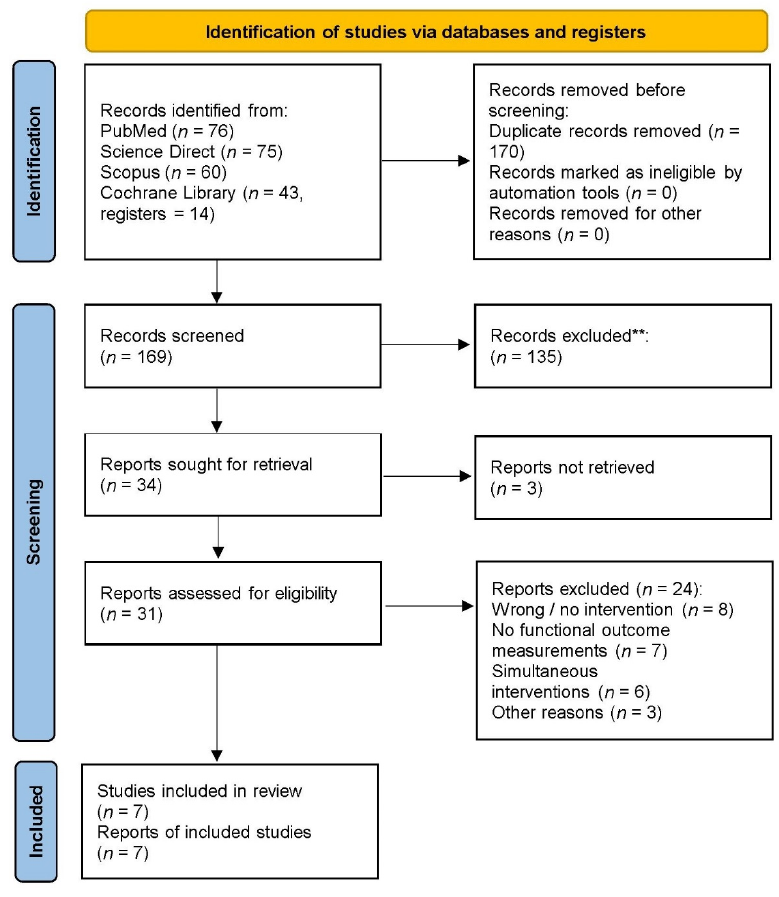
Figure 1. Flowchart diagram of the study selection process. **, irrelevant records excluded